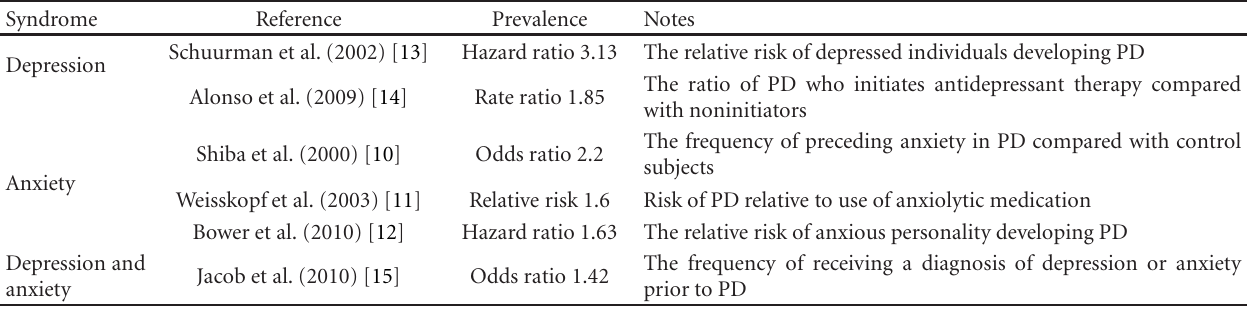
Table 1: Depression and anxiety in pre-motor phase of